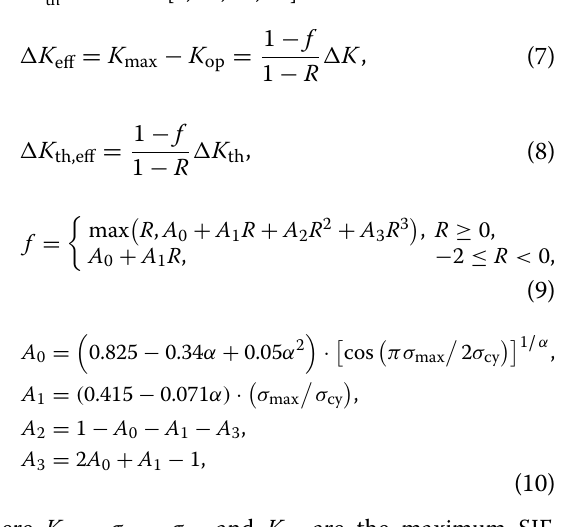
Figure 13 Comparison of predicted FCG curves via upper, lower, and optimal NASGRO models and classical Paris equation with experimental data of weathering steel for: a R